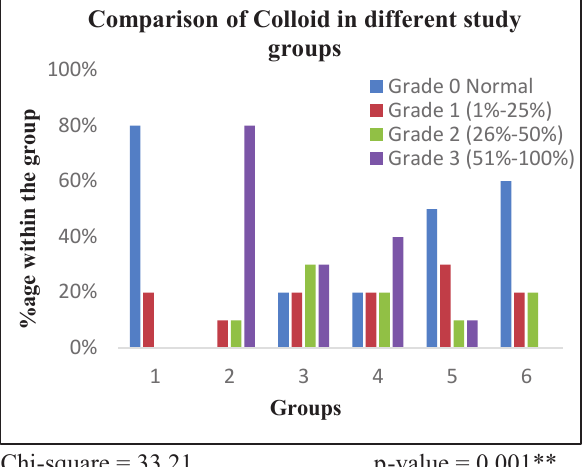
Graph 3: Comparison of Colloid in different study